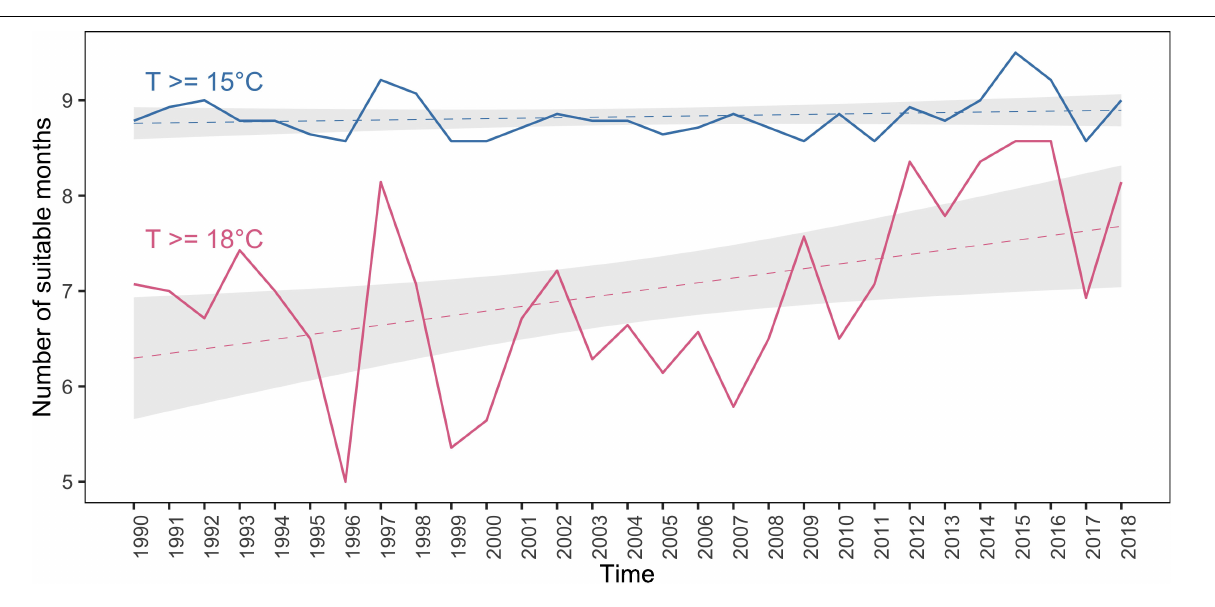
FIGURE 4 | Suitable temperature conditions for malaria transmission in El Oro 1990–2018. Mean (solid curve) number of months per year where minimum temperature exceeds 18 ◦ C (i.e., considered suitable for P. falciparum malaria transmission; pink) and where minimum temperature exceeds 15 ◦ C (i.e., considered suitable for P. vivax malaria transmission; blue), logistic regression line (dashed curve) and 95% confidence intervals (gray